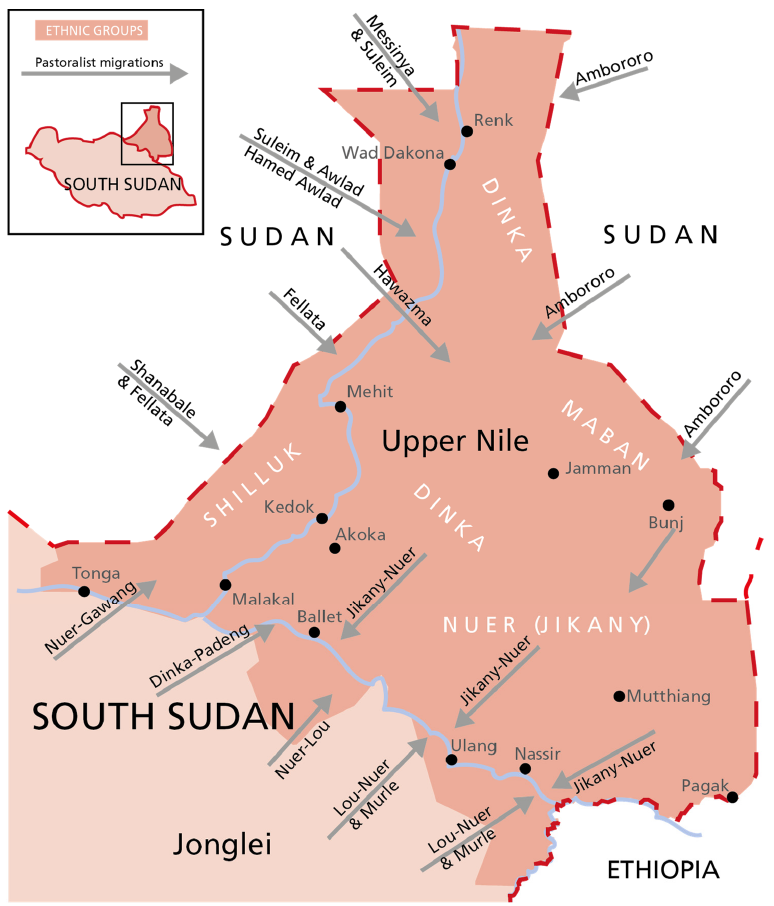
Figure 1. Migration of pastoralists in the former Upper Nile State of South Sudan [35], (p. 89); copyright UNMISS.